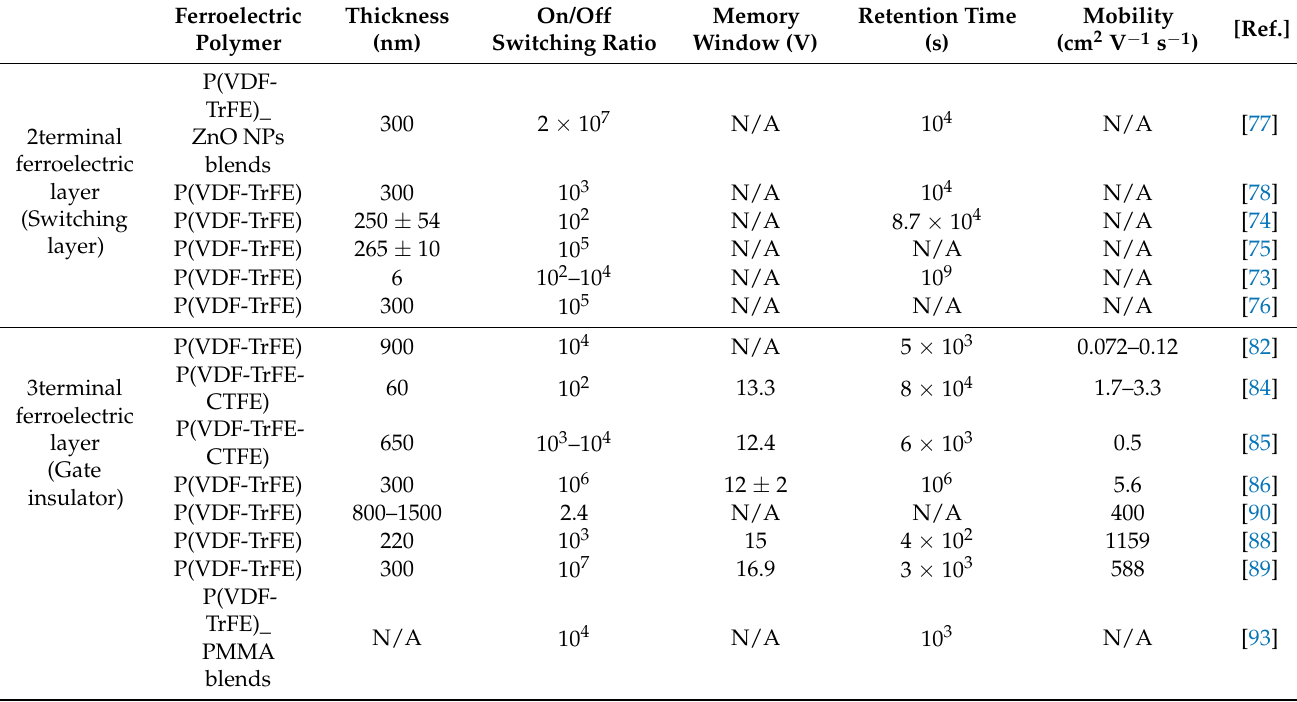
Table 3. Ferroelectric memory characteristics